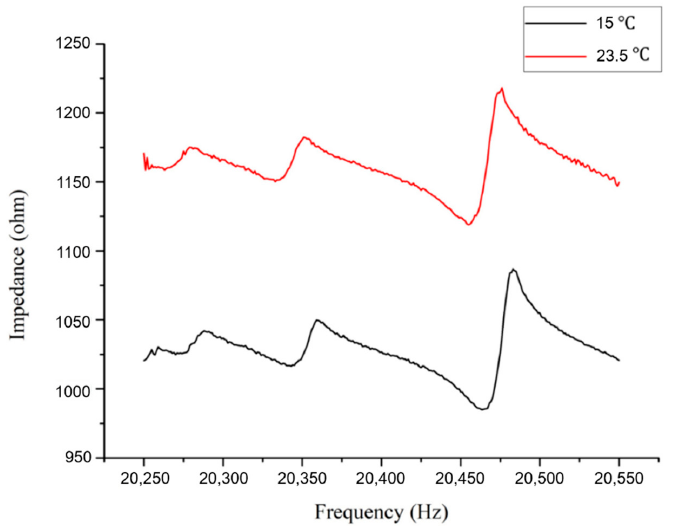
Figure 13. Impedance responses of an undamaged aluminium plate at different temperatures.